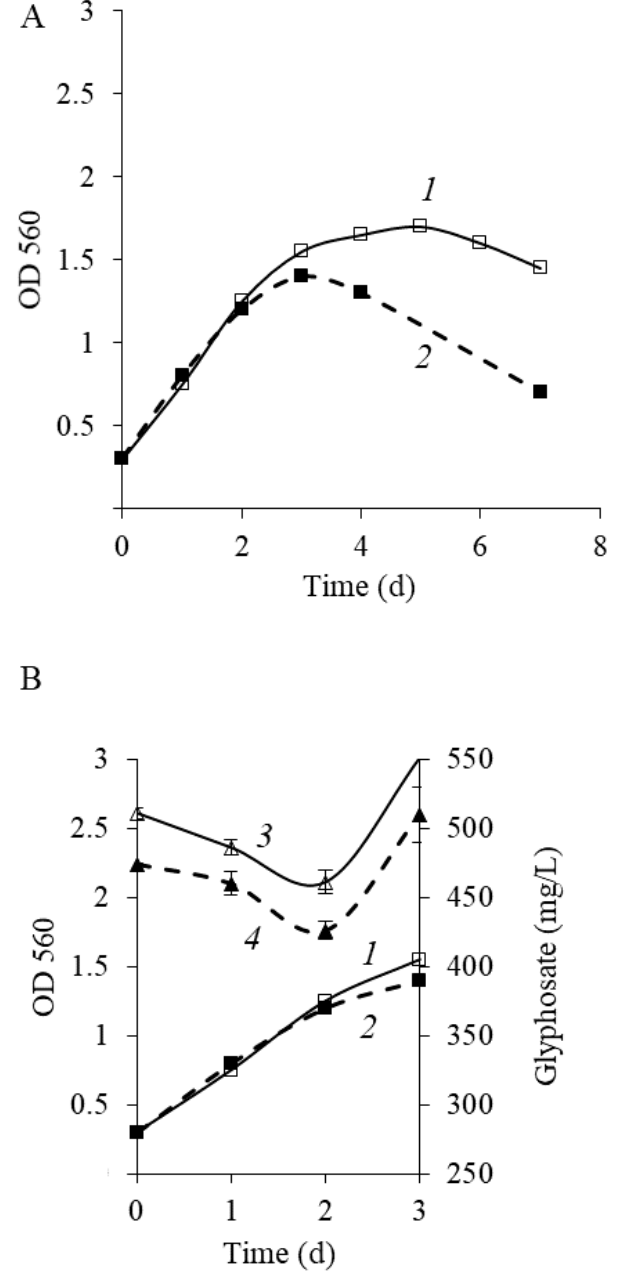
Figure 3. ( A ) Growth dynamics of P. putida strain Ch2 in liquid MS1 medium with glyphosate as a sole phosphorus source: 1—the first passage, 2—the second passage. ( B ) The dynamics of glyphosate consumption by P. putida strain Ch2: 1—OD, the first passage, 2—OD, the second passage, 3—GP concentration, the first passage, 4—GP concentration, the second passage.